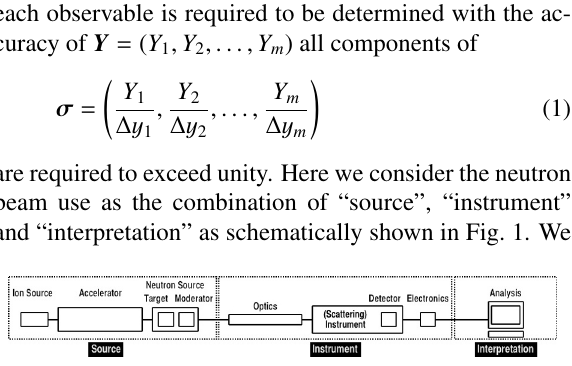
Figure 1. Schematic illustration of the application of the neu- tron beam driven by